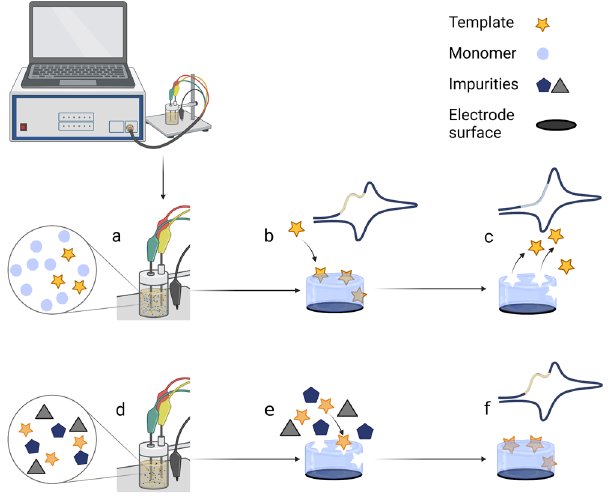
Figure 1. Scheme of the electrochemical polymerisation of the MIP directly on the electrode and the application of the MIP-based electrochemical biosensor: ( a ) polymerisation mixture preparation; ( b ) polymerization of the polymer with template imprints layer on the electrode; ( c ) extraction of the template from the MIP; ( d ) application of the MIP-based sensor; ( e ) competitive interaction of target molecules on the MIP in presence of interferents; ( f ) detection of target molecules. All drawings were designed using Biorender.com, accessed on 26 December